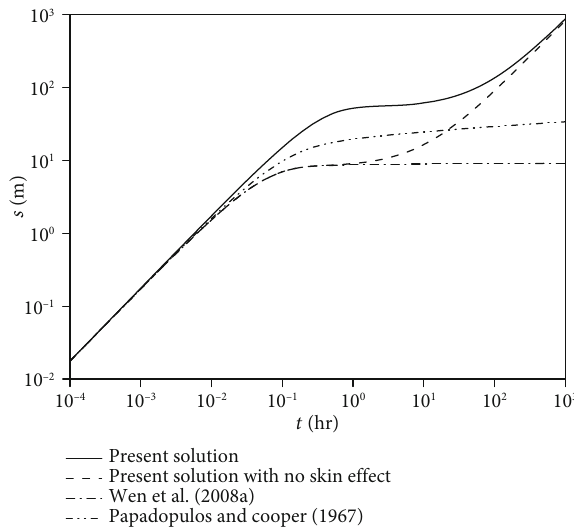
Figure 2: Comparison of the drawdown behavior in pumping well in the present study and the available studies.